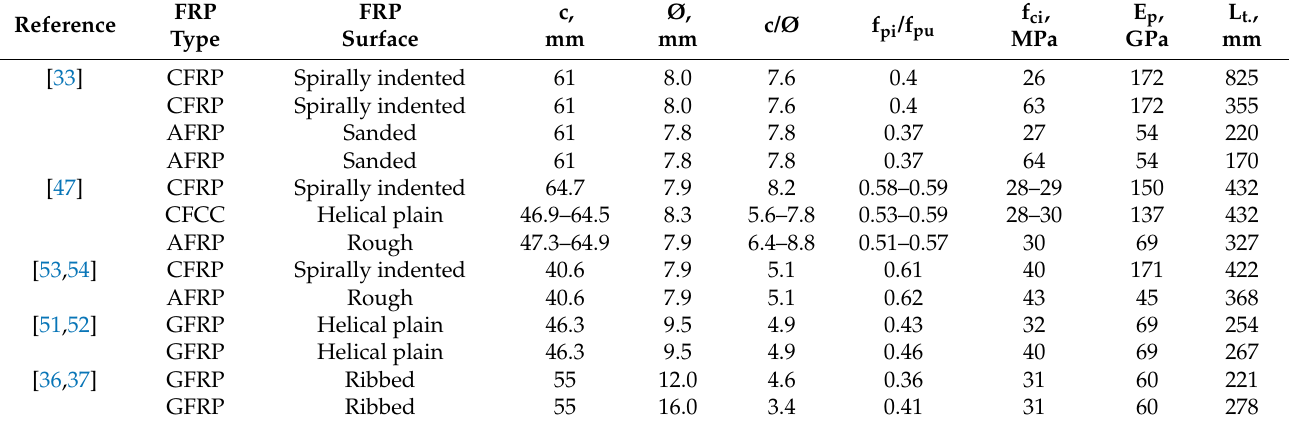
Table 7. Summary of transfer length results on the influence of modulus of elasticity of